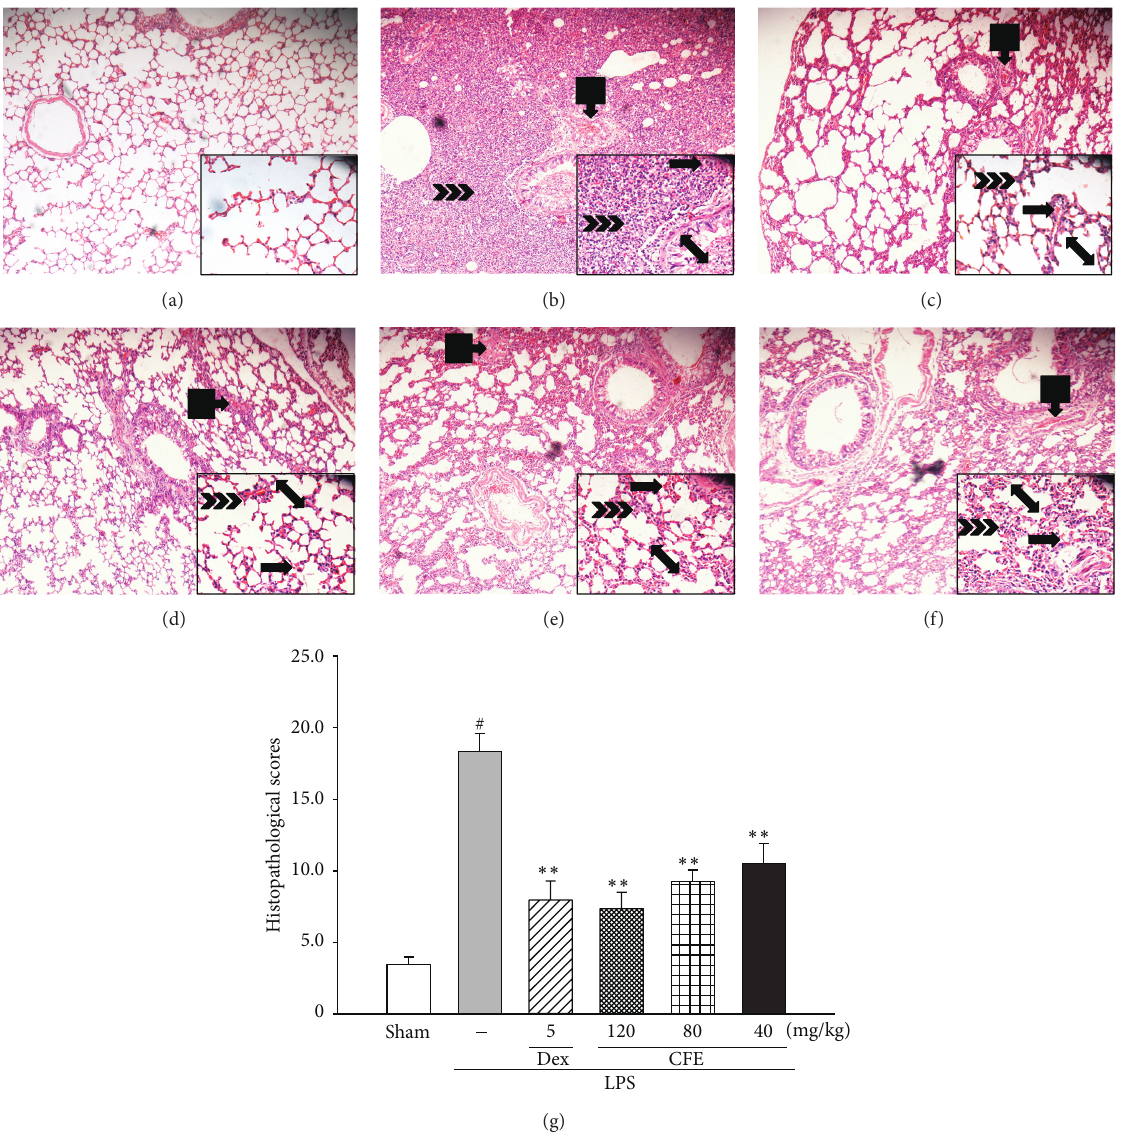
Figure 5: The effects of CFE on histopathological examination. Sham (a), LPS (b), LPS + 5mg/kg Dex (c), LPS + 120 mg/kg CFE (d), LPS + 800 mg/kg CFE (e), LPS + 40mg/kg CFE (f), and histologic changes scorings (G) (100x and 400x). Data was represented as the mean ± SEM ( 𝑛 = 10 ). # 𝑃 < 0.01 compared to the sham group; ∗ 𝑃 < 0.05 and ∗∗ 𝑃 < 0.01 compared to the LPS group. Haemorrhage: ; interstitial edema: ; thickening of the alveolar wall: ; and infiltration of inflammatory cells: .